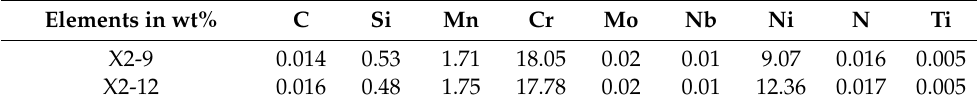
Table 1. Chemical composition of investigated metastable austenitic steels X2-9 and X2-12. Elements in wt% C Si Mn Cr Mo Nb Ni N Ti X2-9 0.014 0.53 1.71 18.05 0.02 0.01 9.07 0.016 0.005 X2-12 0.016 0.48 1.75 17.78 0.02 0.01 12.36 0.017